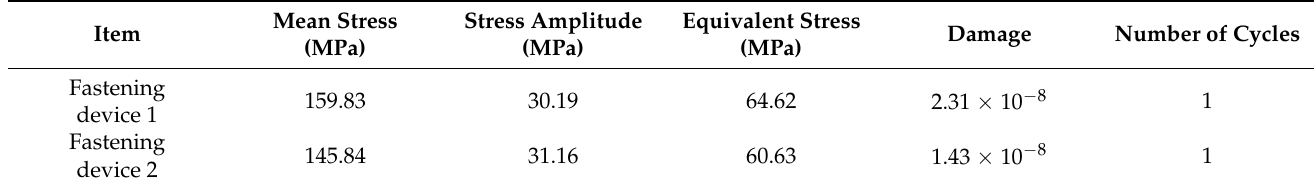
Table 5. Maximum damage condition at each fastening device when loading part is lifted.